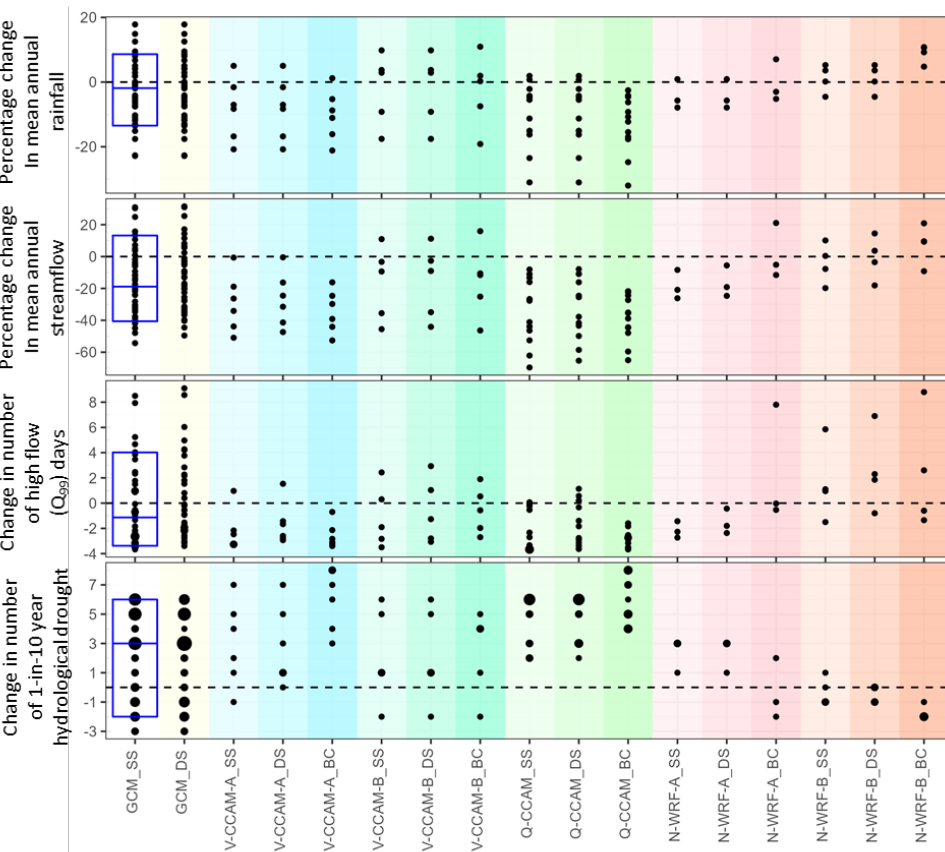
Figure 6. Modelled changes in the mean annual rainfall, mean annual streamflow, high flow days, and hydrological drought from the different climate projection products and methods used to generate future daily rainfall series for Catchment 401212 Nariel Creek at Upper Nariel (acronyms for the datasets and methods on the x -axis are described in Table 1 and Section 2, definitions for high flow days and the 1-in-10-year hydrological drought on the y -axis are described in the first paragraph of Section 3, blue boxes for GCM_SS show the median and 10th and 90th percentile ranges from the simulations informed by the 42 GCMs; for the discrete (integer value) hydrological drought, metric larger dots indicate more modelling results showing the projected change).